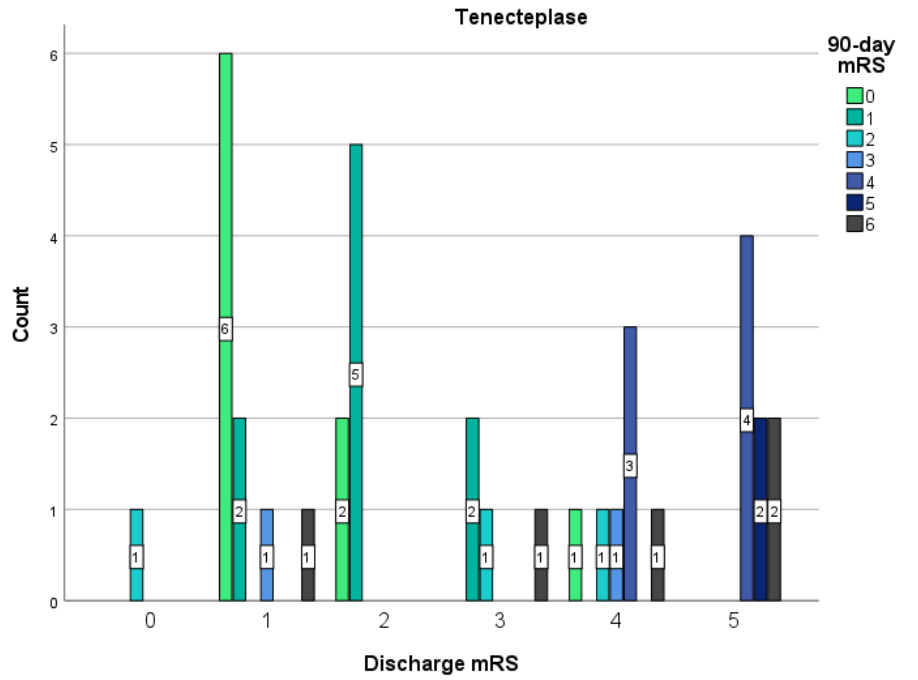
Figure 1. Distribution of the discharge mRS and the 90-day mRS between patients treated with Tenecteplase. Shown is the distribution of scores for disability on the modified Rankin Scale (which ranges from 0 to 6, with higher scores indicating more severe disability, and 6 indicating death) among patients in the Tenecteplase group during discharge and after 90 days. The bars indicate the mRS results after 90-days. The numbers in the bars are the count of patients who had each score after 90-days.